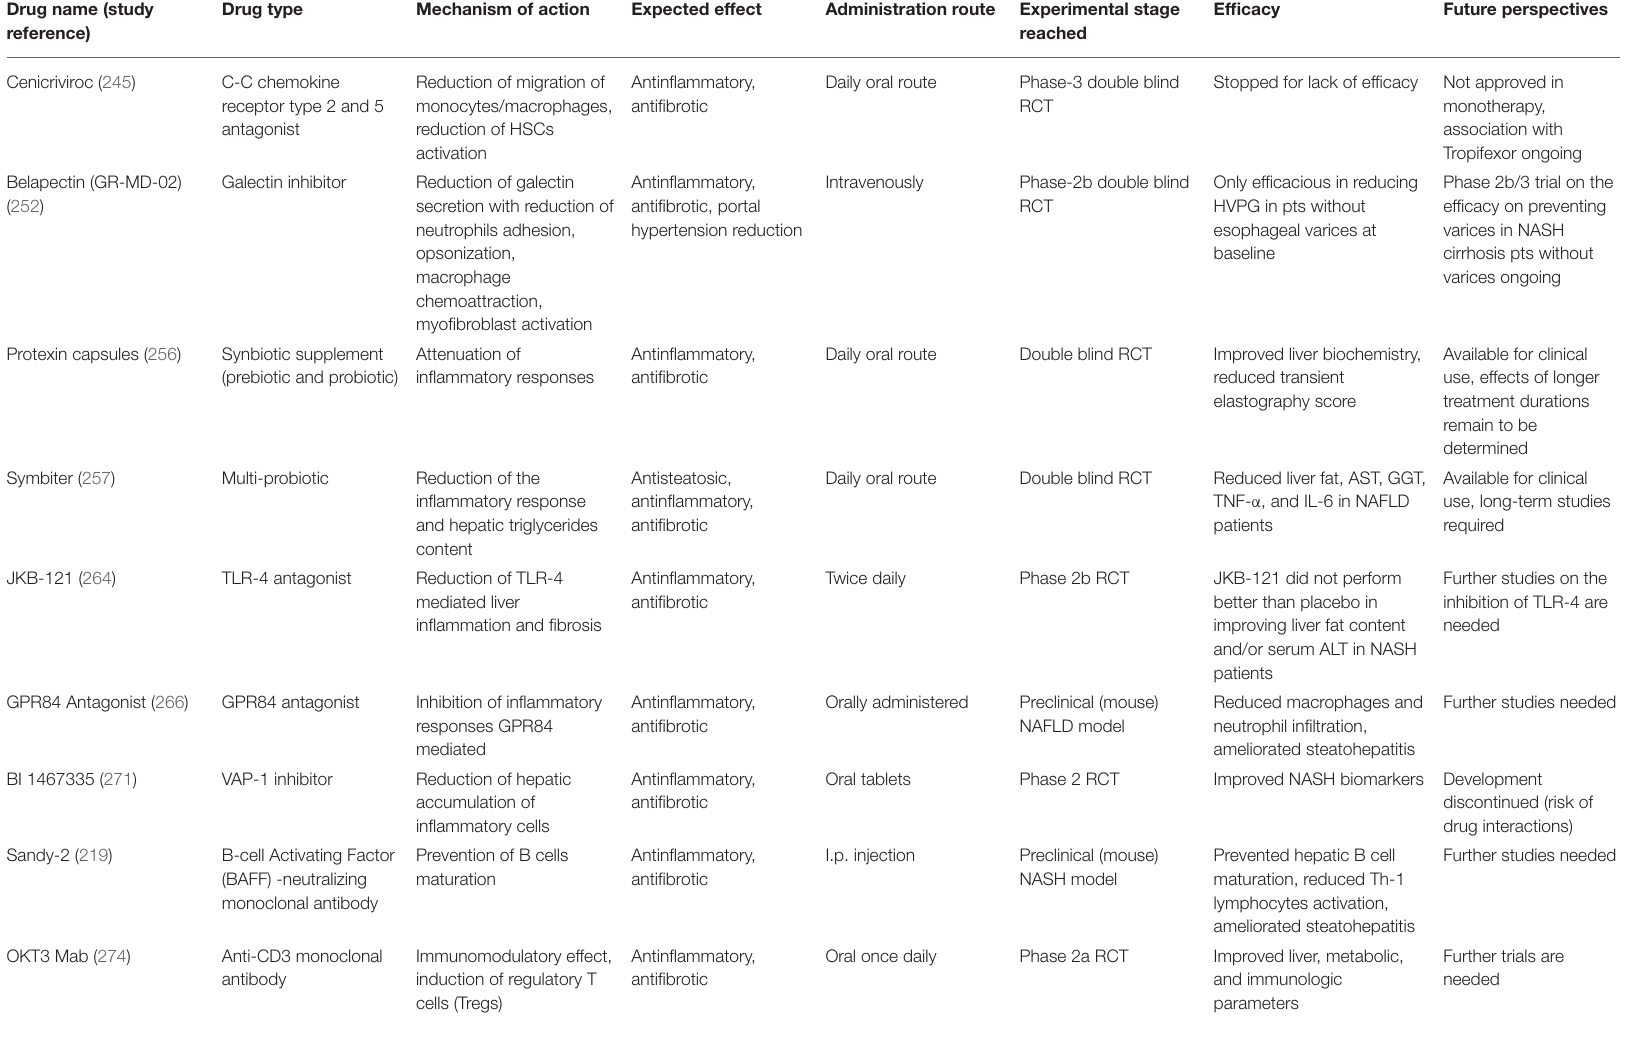
TABLE 1 | Summary of the drugs recently studied for NAFLD therapy which have a mechanism of action that involves immune system